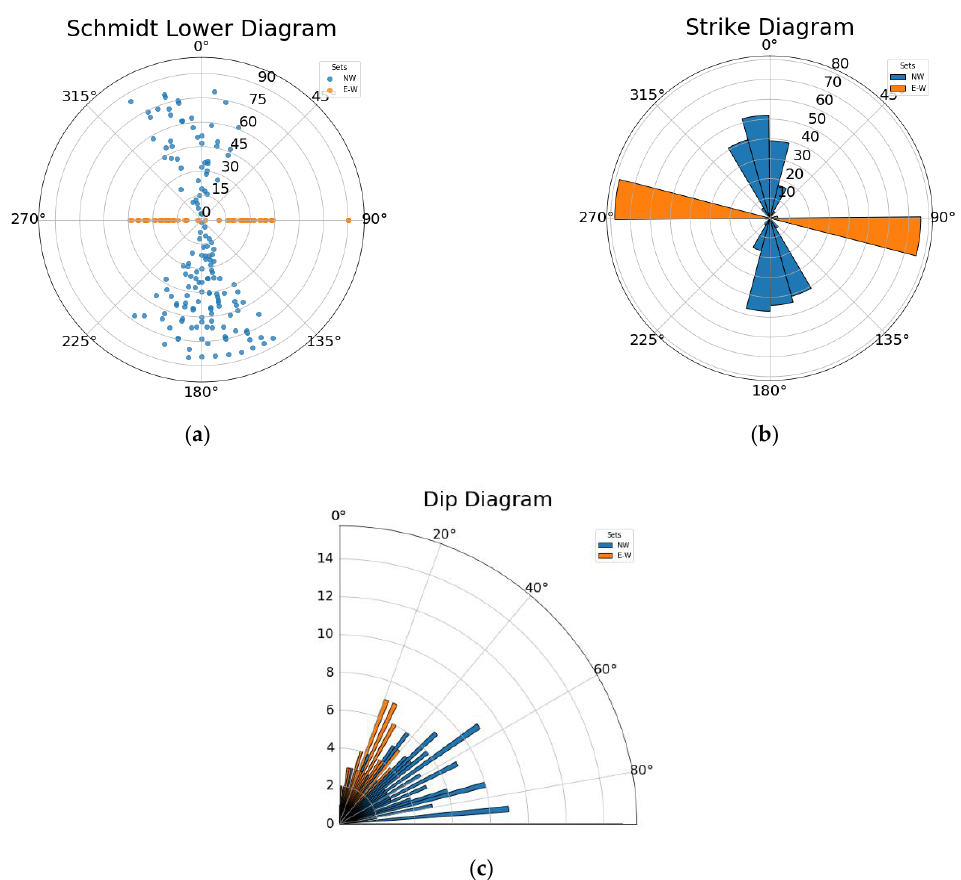
Figure 9. Example of Wellbore fractures spatial attributes that were identified in well B5: ( a ) Stereo net plot; ( b ) rose diagram; and ( c ) dip diagram.